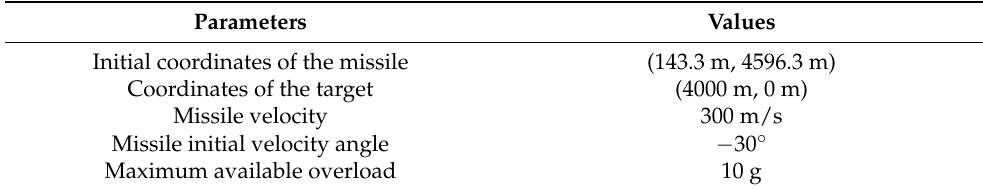
Table 1. Initial conditions for homing engagement.